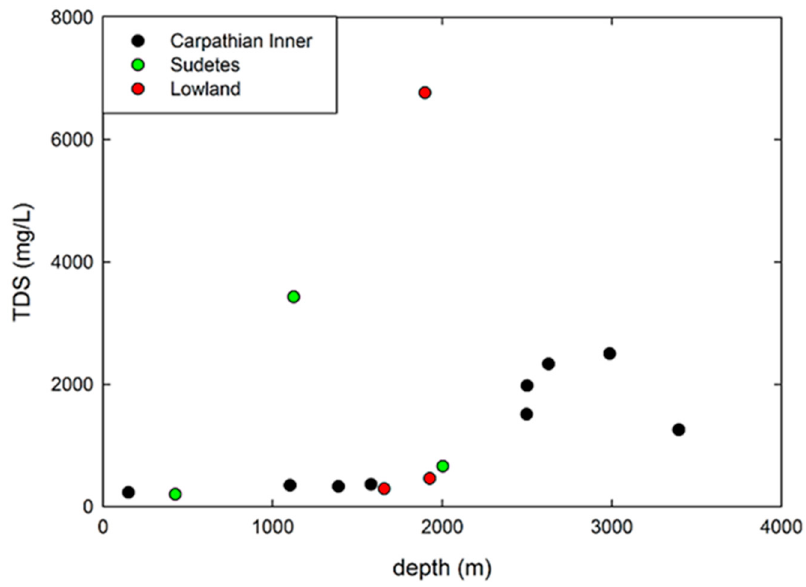
Figure 4. Relationship between water mineralisation and depth aquifer.